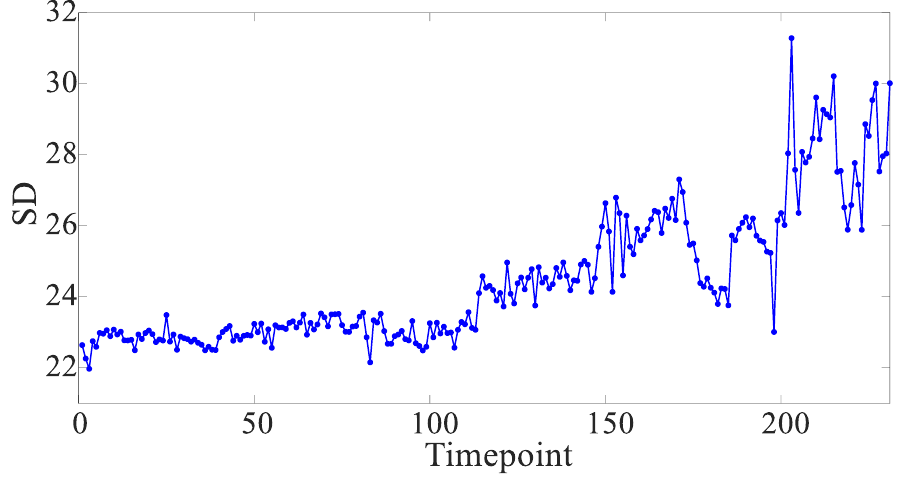
Figure 6. SD of the original axial A-directional vibration waveform.